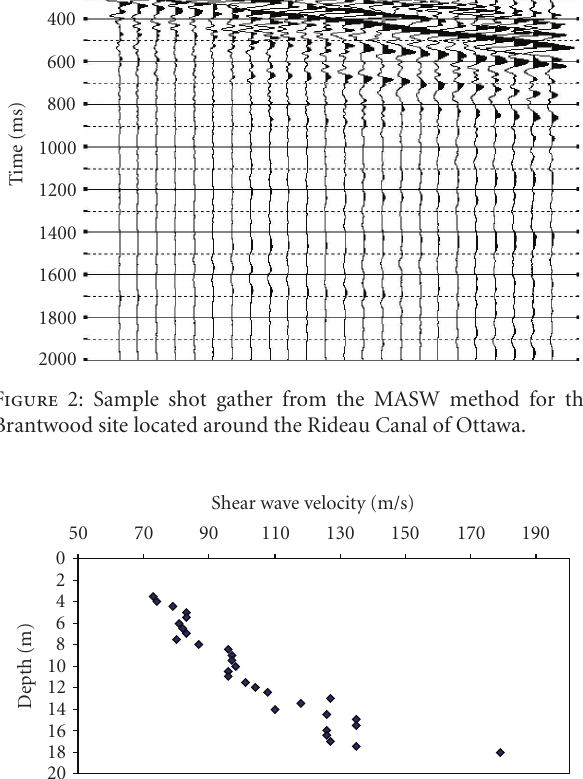
Figure 3: Depth-shear wave velocity profile from borehole data for NRC site.